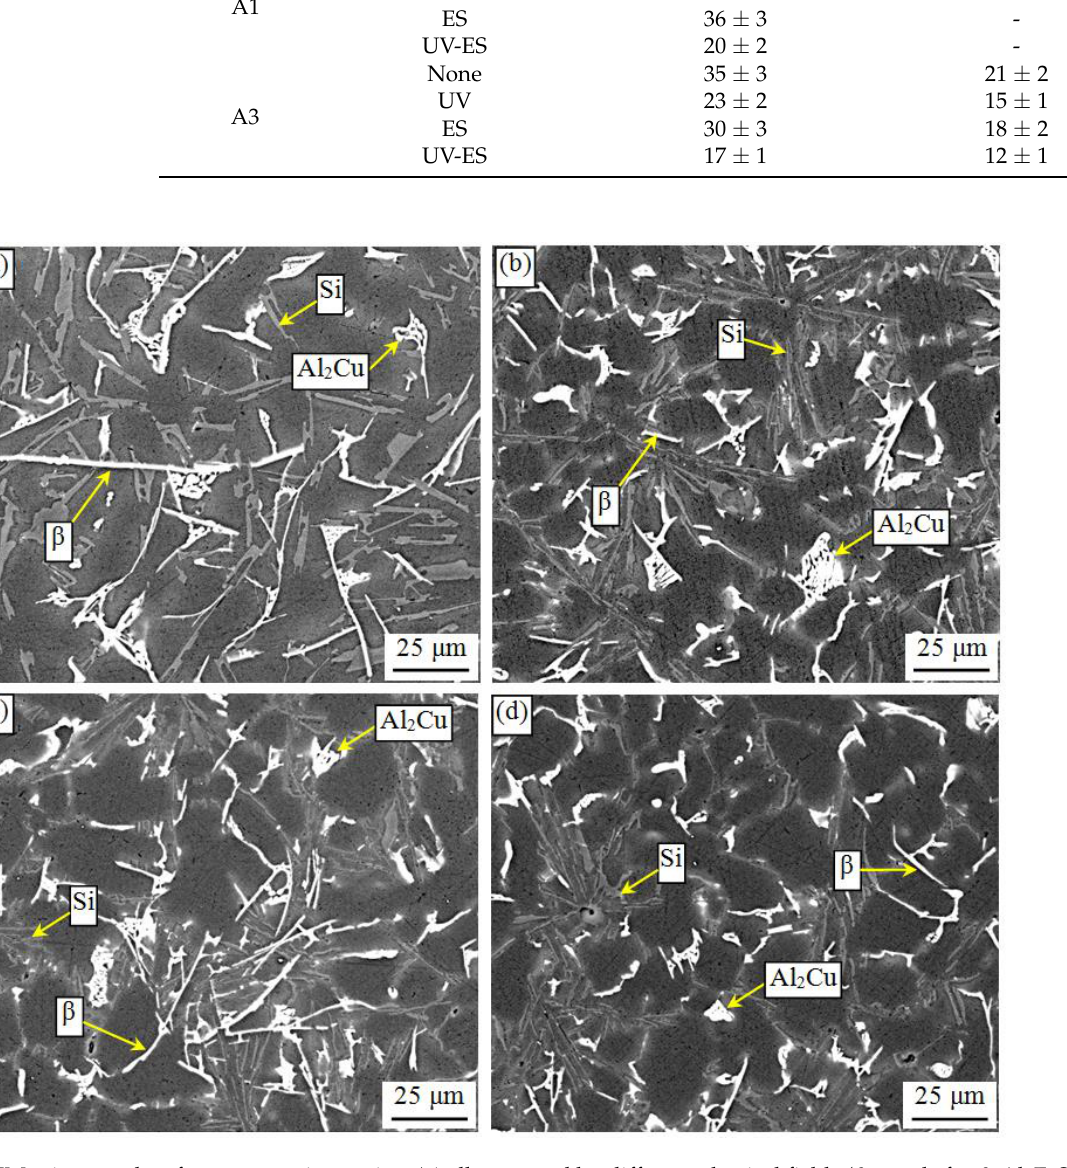
Figure 6. SEM micrographs of as-cast gravity casting A1 alloy treated by different physical fields (β stands for β-Al 5 FeSi): ( a ) no treatment; ( b ) UV; ( c ) ES; ( d ) UV-ES.